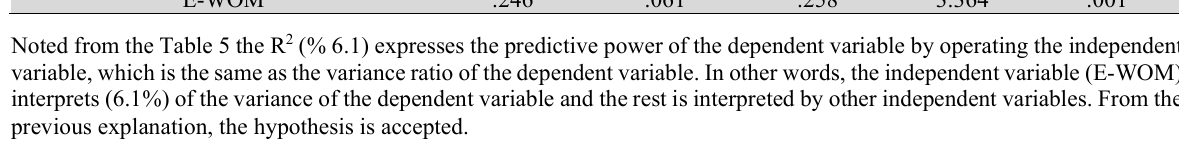
Simple Linear Regression for Examining the Effect of E-WOM on Customer Purchase Intention Independent Variable R R 2 B t Sig(T) E-WOM .246 .061 .258 3.364 .001